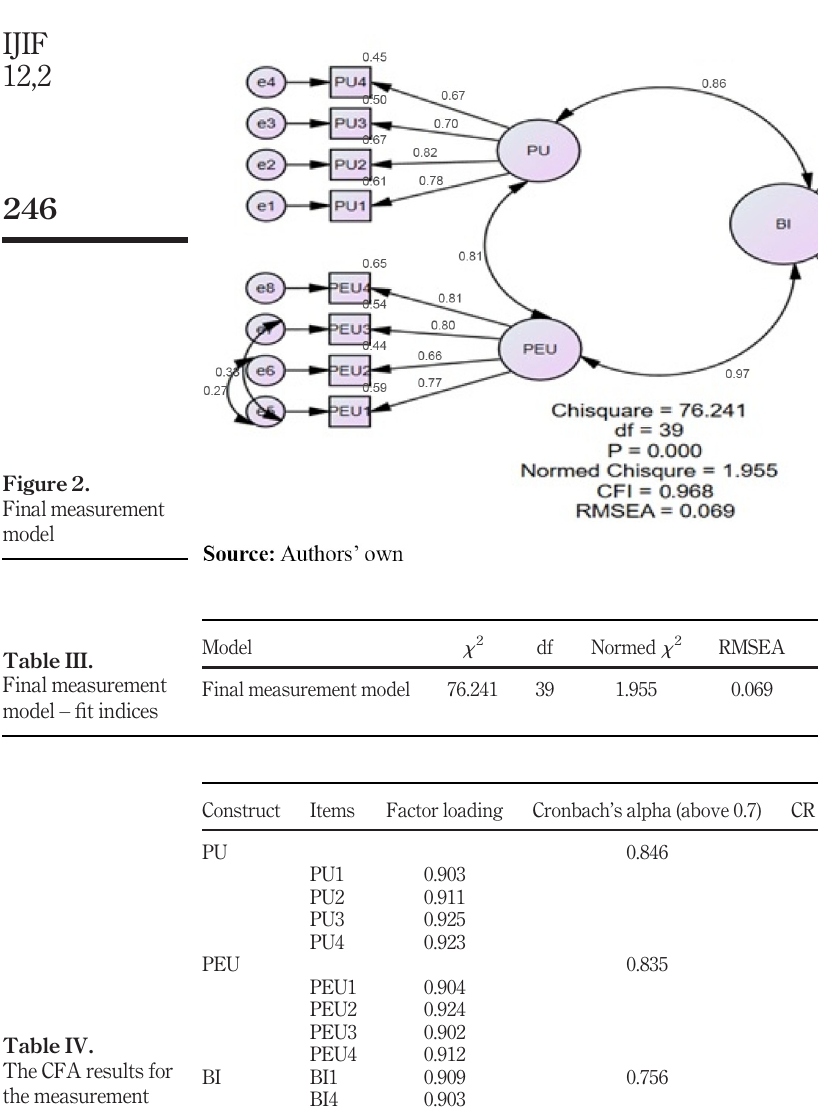
Table IV. The CFA results for the measurement